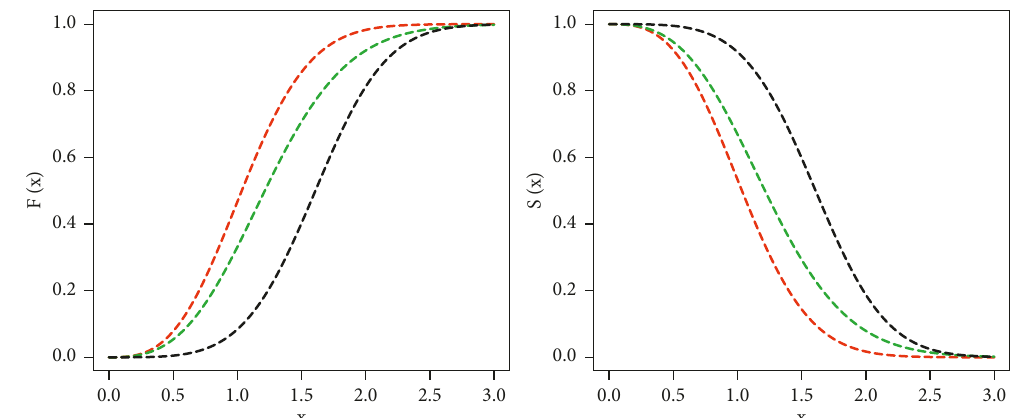
Figure 1: Graphical representation of F ( x ; δ , λ ) and S ( x ; δ , λ ) .